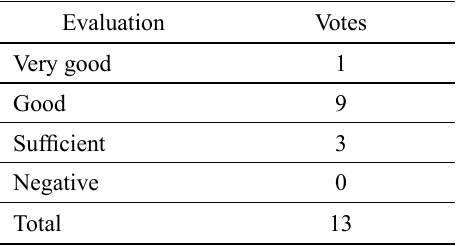
Table 11. Evaluation of available technological resources and ICT training Evaluation